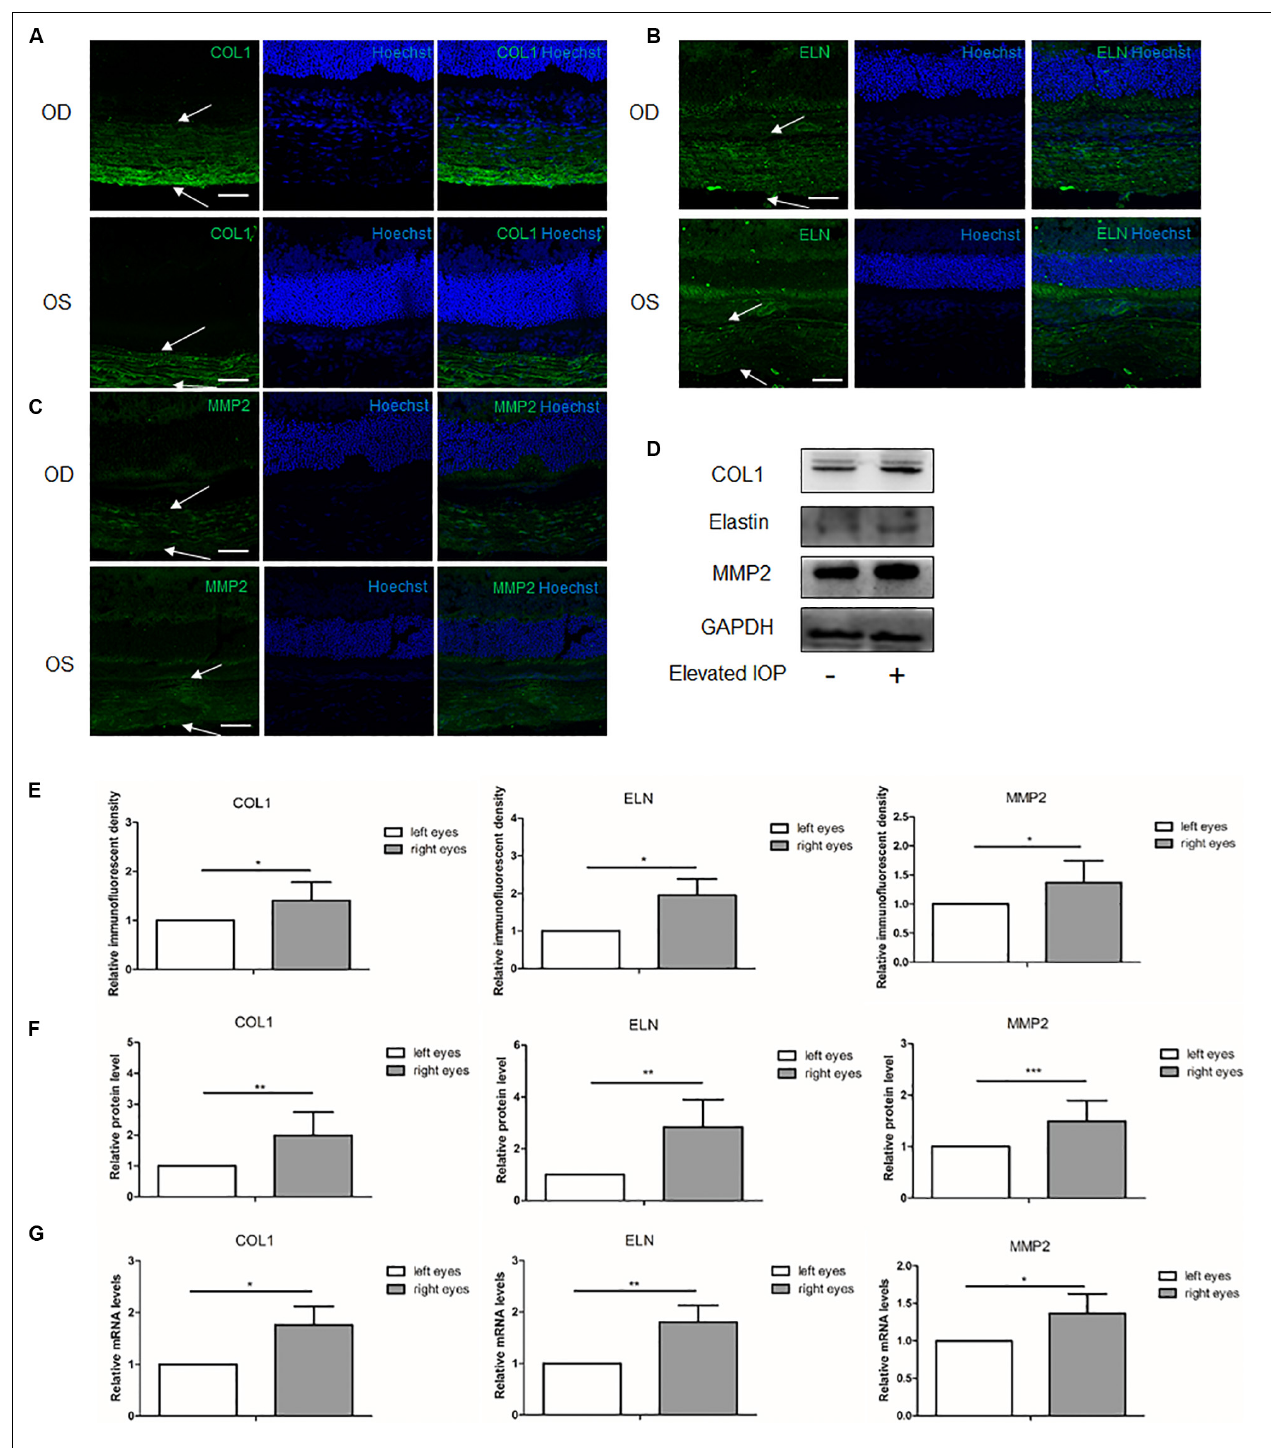
FIGURE 2 | Expressions of the scleral extracellular matrix (ECM) components under chronic elevated intraocular pressure (IOP) for 1 week. The ocular hypertension model was established for 1 week in rats. Immunohistochemical staining showed the scleral (A) collagen I ( green ), (B) elastin ( green ), and (C) matrix metalloproteinase 2 (MMP2, green ) expressions in the hypertensive right eyes ( OD ) and the contralateral left eyes ( OS ). White arrows indicate the sclera. Scale bar , 50 µ m. (D) Immunoreactive bands of collagen I, elastin, and MMP2 in the contralateral left eyes and the hypertensive right eyes. (E) Semi-quantitative analysis of the immunofluorescent images ( n = 5). Quantification of the protein expressions (F ; n = 8) and mRNA levels (G ; n = 6) of collagen I, elastin, and MMP2. GAPDH was set as the housekeeping gene. Data were demonstrated as the mean ± SD of three replicates. * P < 0.05; **0.001 < P < 0.01; and *** P < 0.001.